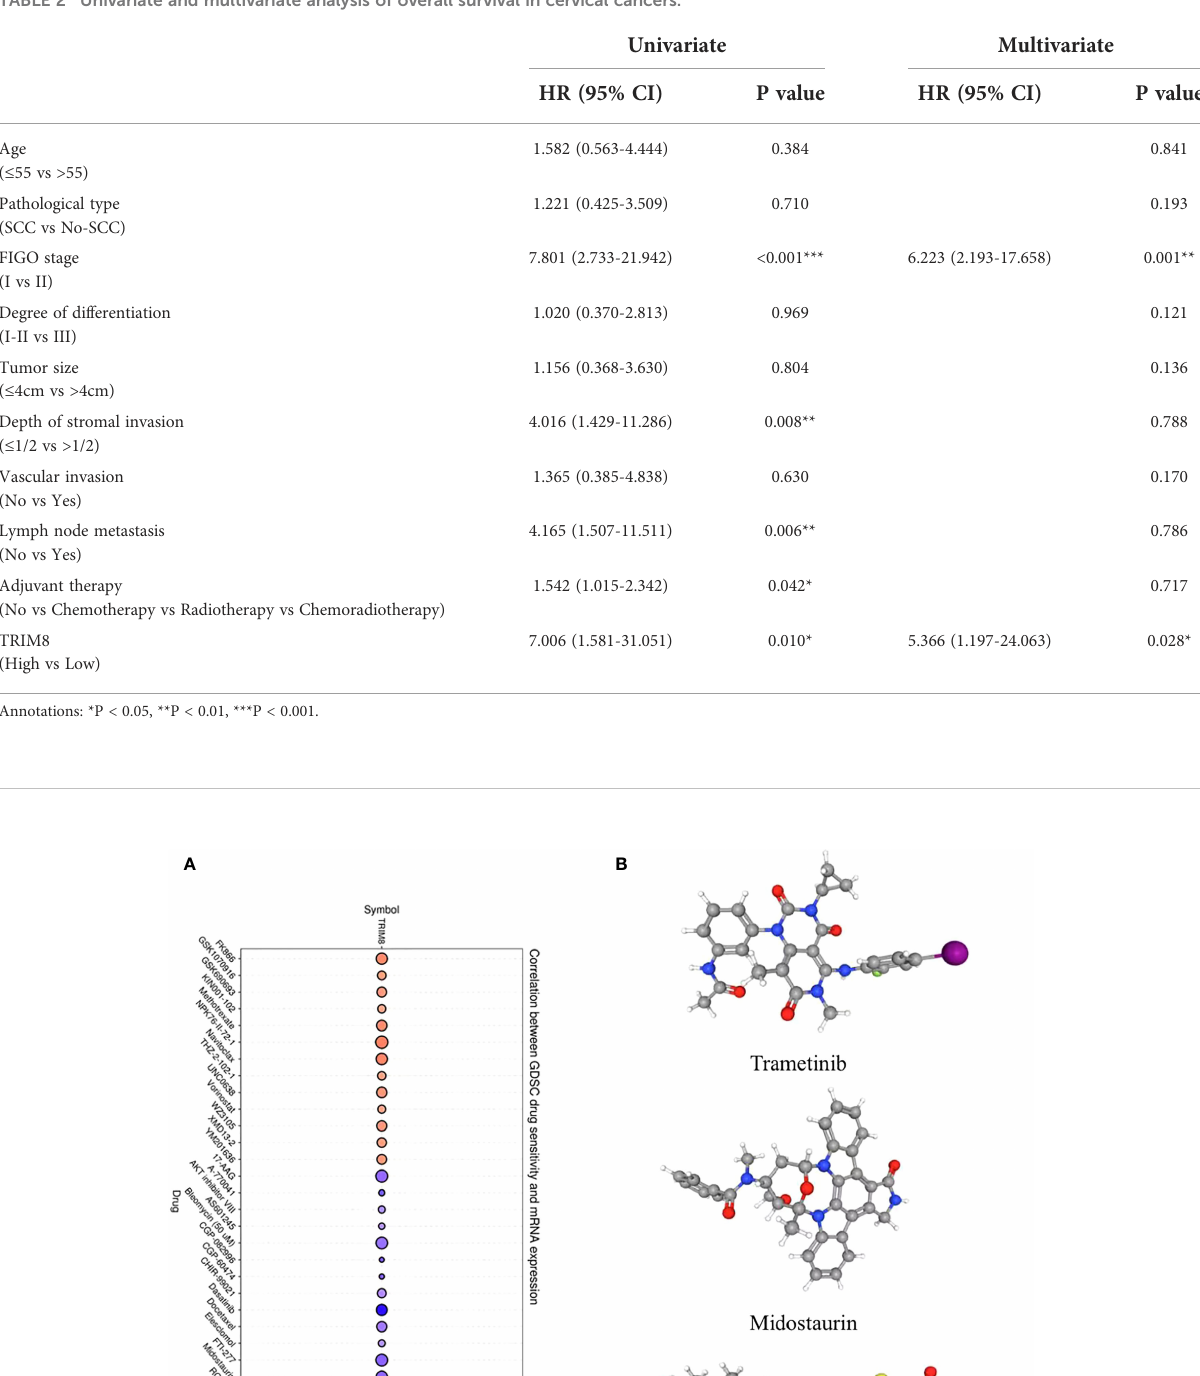
TABLE 2 Univariate and multivariate analysis of overall survival in cervical